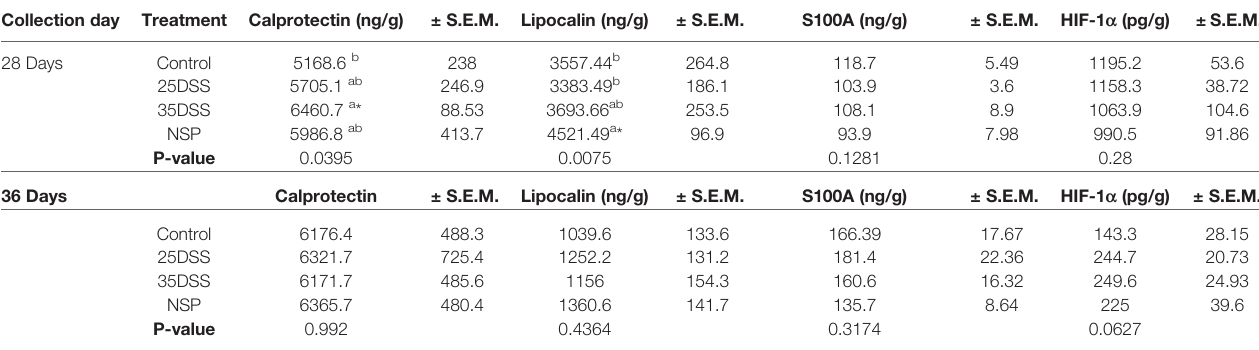
TABLE 8 | Biomarker concentration on excreta of broilers submitted to different intestinal challenges at 28 and 36 days of age. The broilers challenged with DSS received 0.25mg/ml (25DSS) or 0.35mg/ml (35DSS) of DSS via oral gavage everyday from 9 to 14-d and 23 to 27-d; birds in the NSP treatment received a diet with 30% of rice bran during the whole experiment, and animals in the control group were not submitted to any challenge. Collection day Treatment Calprotectin